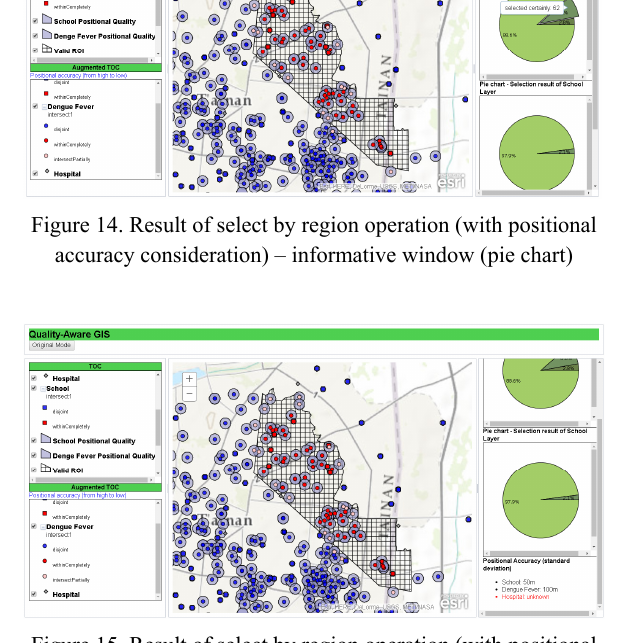
Figure 15. Result of select by region operation (with positional accuracy consideration) – informative window